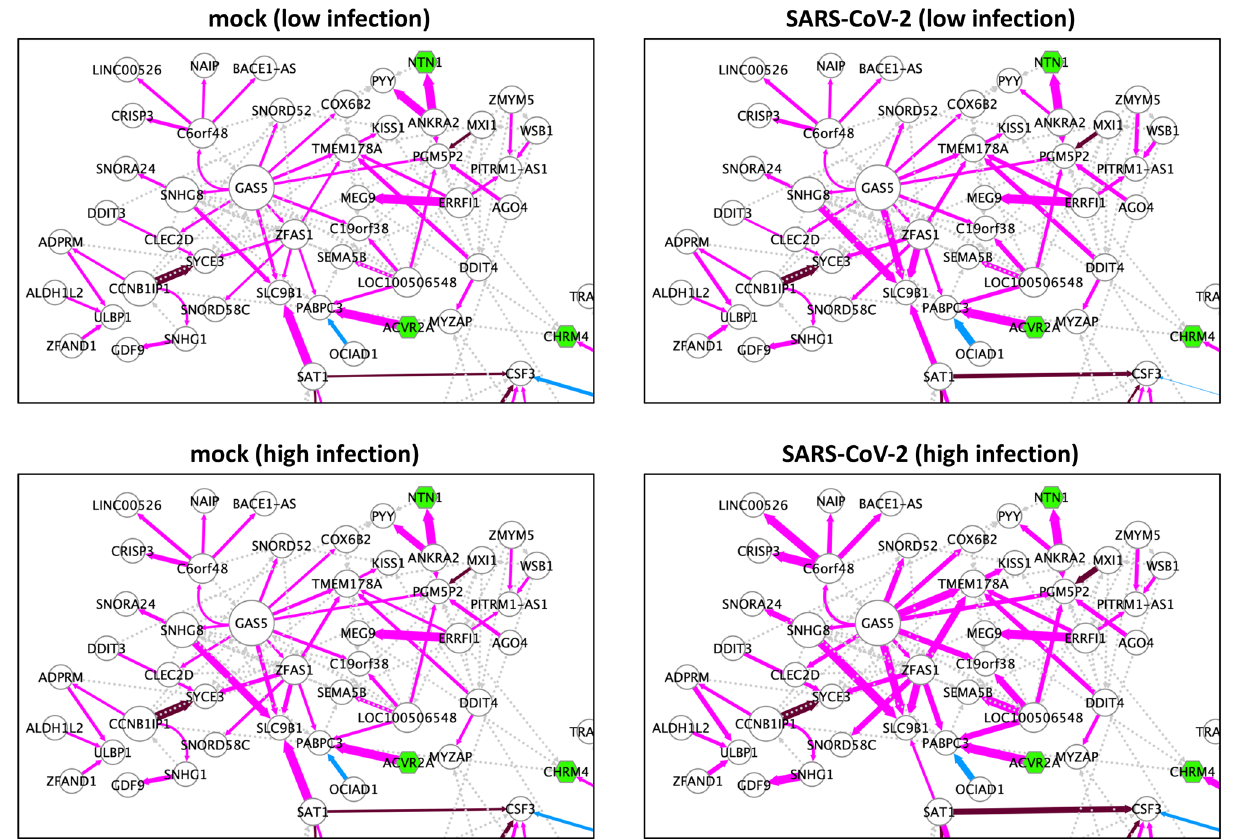
Figure 4. Sample-specific individual networks around the GAS5-centralized module. The GAS5-centralized module (module 3) in the SARS-CoV-2-perturbed network (presented in Fig. 3) is displayed for four representative samples from each group (mock for SARS-CoV-2-infection (low MOI: 0.2), SARS-CoV-2- infected (low MOI: 0.2), mock for SARS-CoV-2-infection (high MOI: 2), and SARS-CoV-2-infected (high MOI: 2)). RCs are represented as edge sizes to show individual differences. The node size represents the extent of